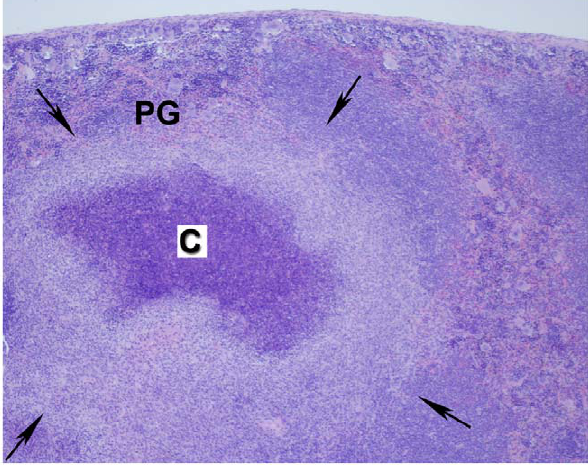
Figure 4. Pyogranulomatous inflammation of the spleen. Cross section showing pyogranulomatous inflammation (PG,) wherein arrows delineate borders of the pyogranuloma. The center has caseous necrosis (designated by C; shown at 4X magnification). Details of processing and staining of the tissue are described in Materials and Methods.